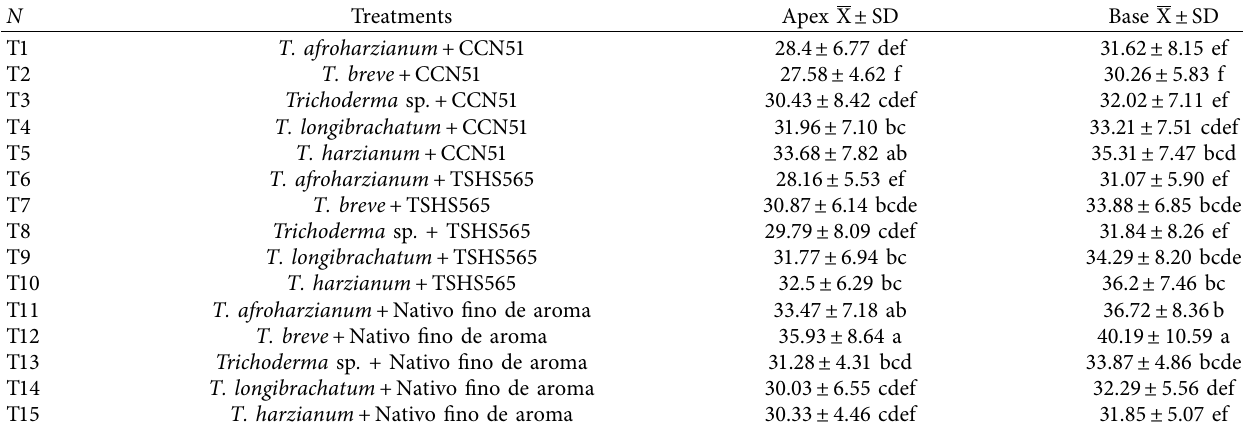
Table 2: Chlorophyll index (SPAD) in the leaf apex and base by treatments.